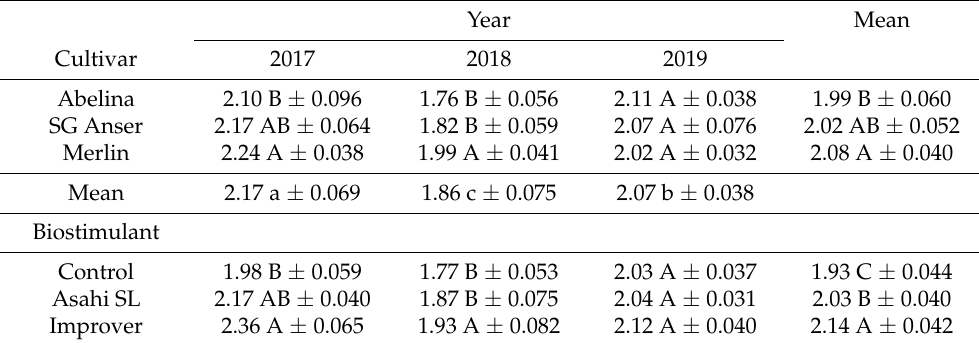
Table 5. Seed number per pod according to years, cultivars, and biostimulants.